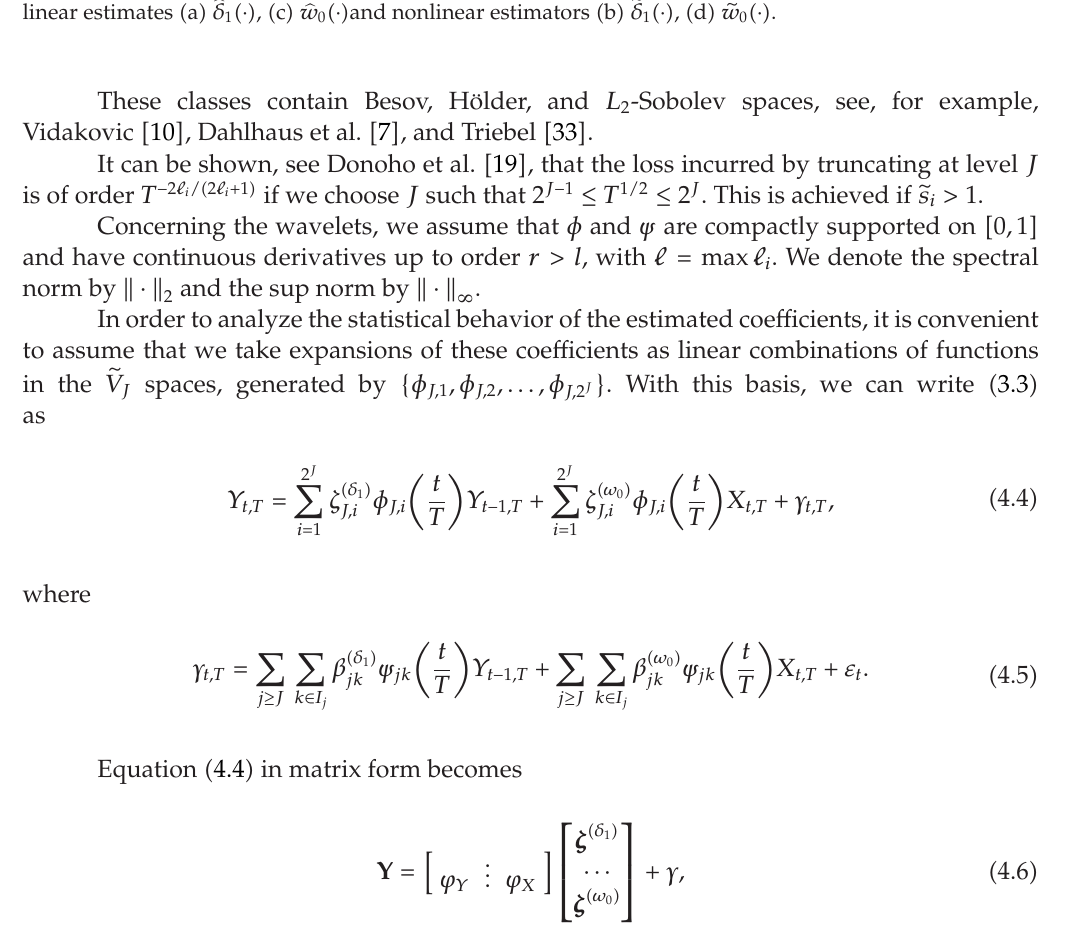
(cid:5) · (cid:6) , (cid:5) d (cid:6) (cid:5) w (cid:5) · (cid:6) 1 0